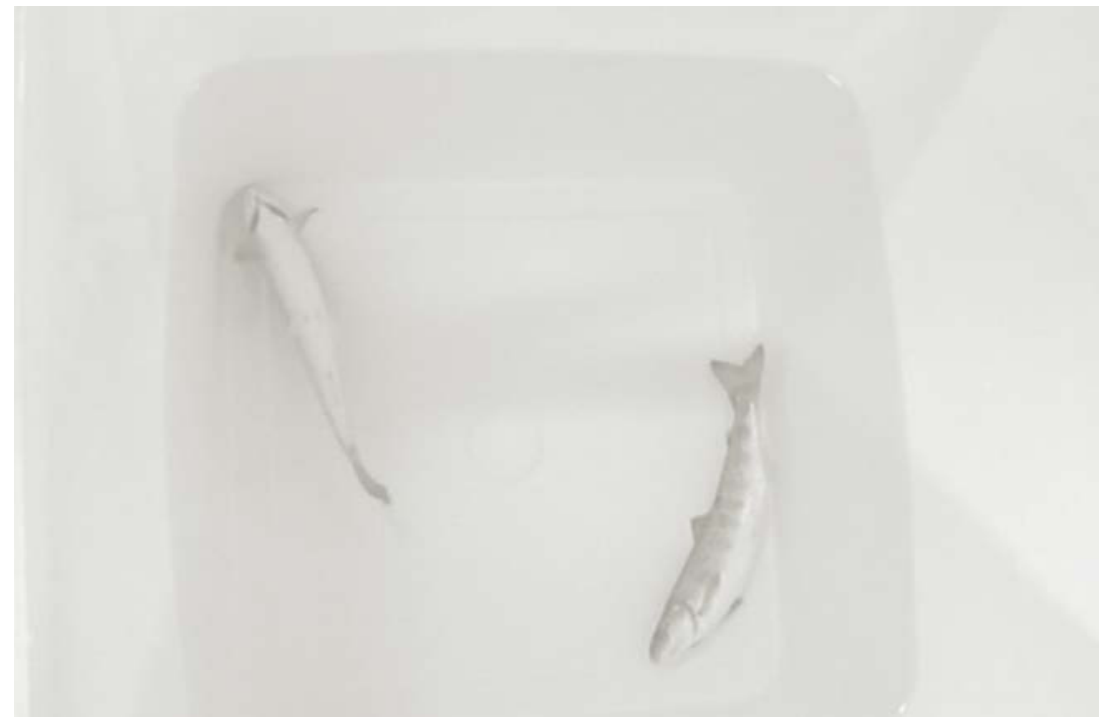
Figure 2. Anesthetized fish that have lost the righting up reflex and have sunk to the bottom of the tank, resting on their backs.